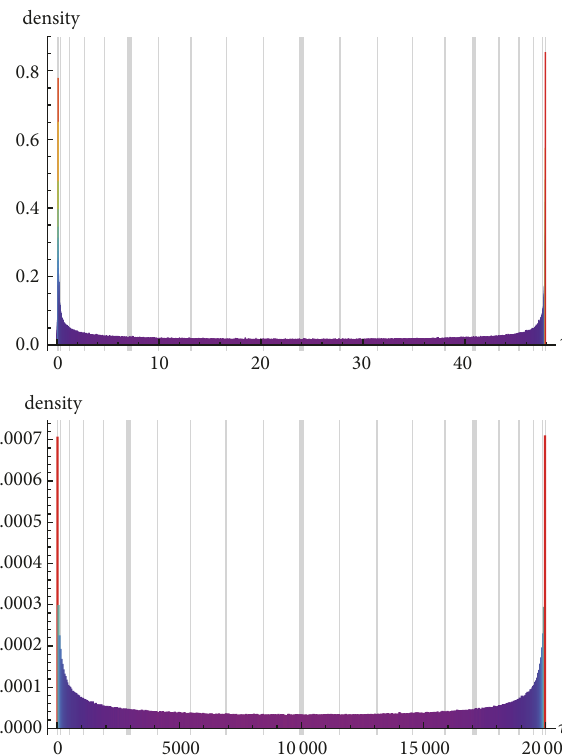
Figure 5: Distributions of tunneling decay times 𝜌 𝑡 (𝜏) through the barrier of the potential 𝑉 2 (𝑥) for the initial bound state 𝜙 0 (𝑥) given by (18). The histograms were built by using the Monte Carlo procedure described in Figure 2 and in the main text. The vertical grey lines indicate percentiles of the distribution (the first and the last correspond to 1 % and 99 %, the remaining ones range from 5 % to 95 %, in steps of 5 %); the three thick vertical lines indicate the first quartile (percentile 25 %), the median, and the third quartile (percentile 75 %). Rydberg atomic units were used in all the plots. Top: barrier width 𝑏 − 𝑎 = 2 and bin length ≈ 0.0031𝑎.𝑢. ( ≈ 0.15 attoseconds). Bottom: barrier width 𝑏−𝑎 = 4 and binlength ≈ 40𝑎.𝑢. ( ≈ 1,935